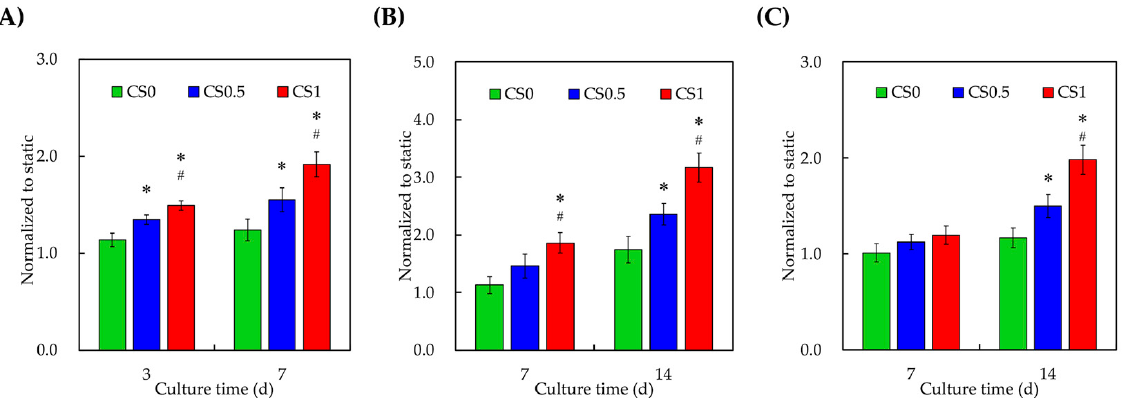
Figure 9. Levels of ( A ) ALP; ( B ) OPN; and ( C ) OC expressions from hPDLs cultured in CS0, CS0.5, and CS1 for 3 and 7 days. hPDLs growing on traditional culture dishes were used as Ctl. Data presented as mean ± SEM, n = 6 for each group. A p -value of < 0.05 was considered as a significant difference according to the calculation of Scheffe’s multiple comparison test. * represents significant differences when compared to CS0 and # represents significant differences when compared to CS0.5.